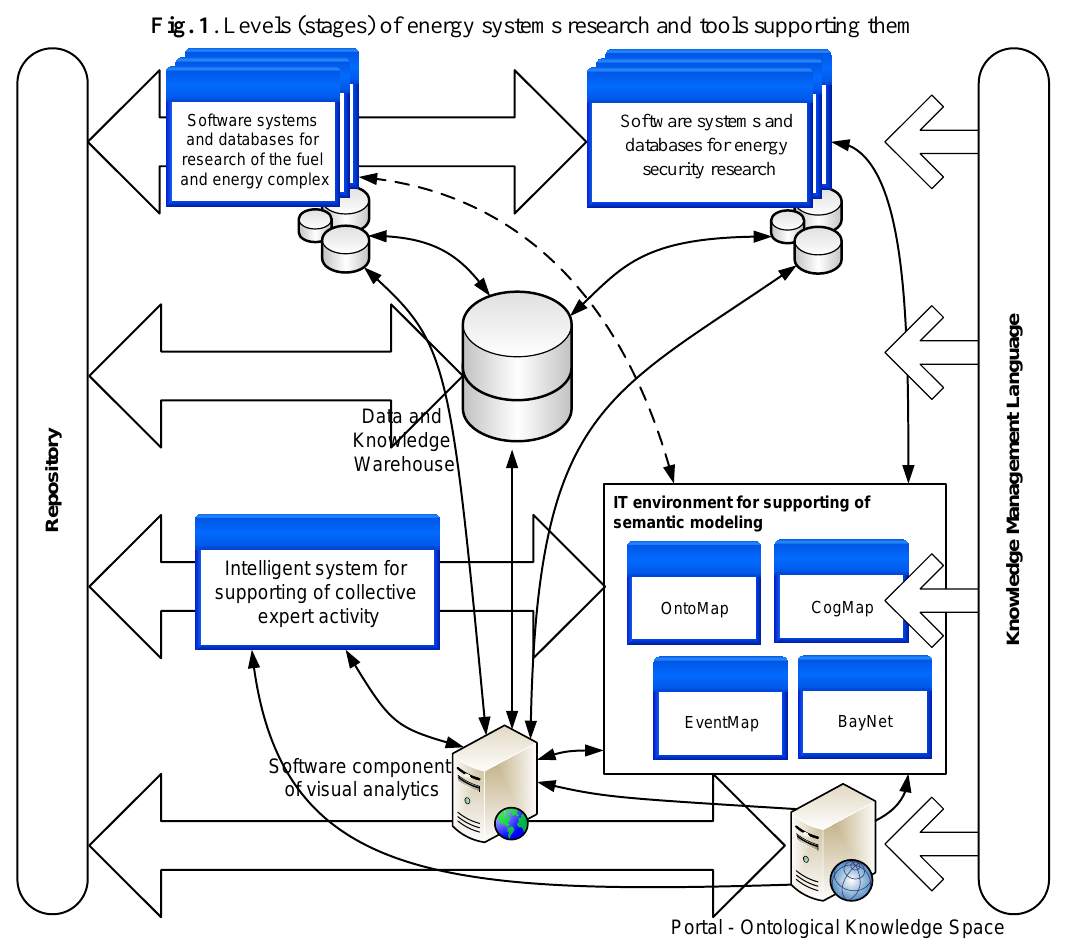
Fig. 2. The architecture of the multi-agent intelligent environment